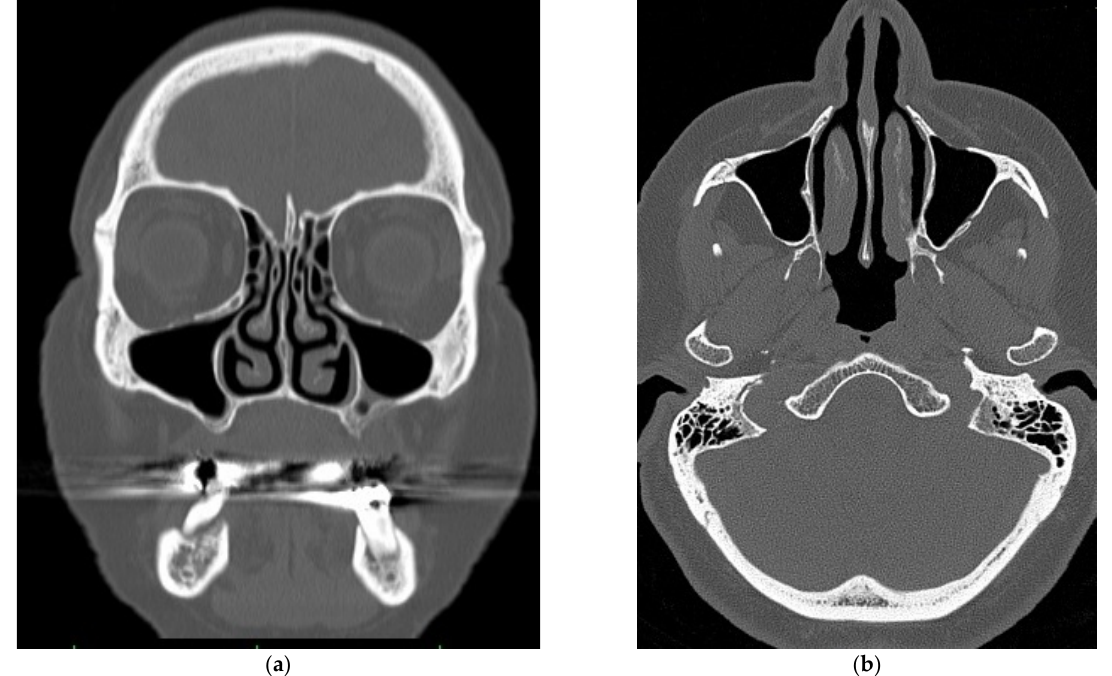
Figure 1. CT images of the nasal cavity—( a ) frontal section ( b ) transverse section.